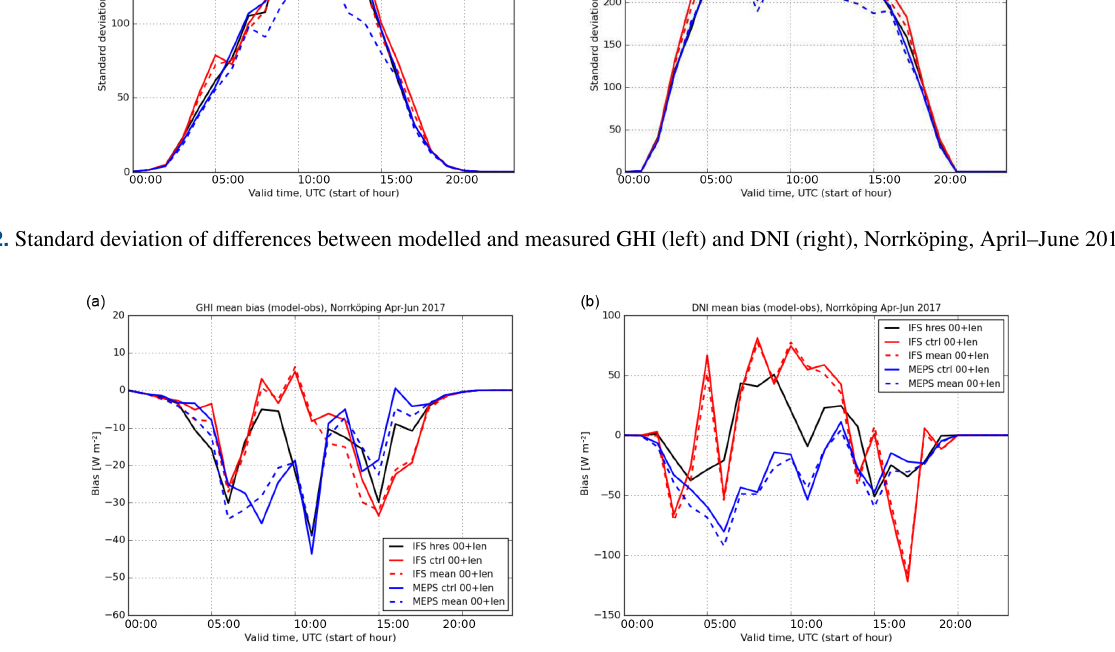
same way as in the IFS